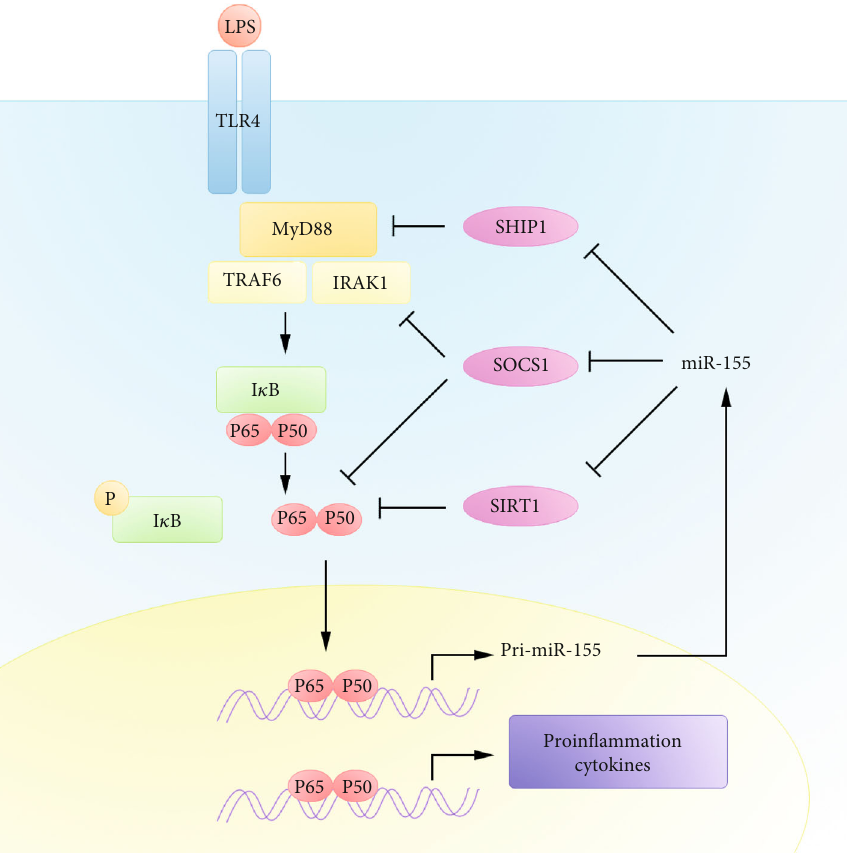
Figure 2: miR-155 modulates TLR4 signaling pathway in